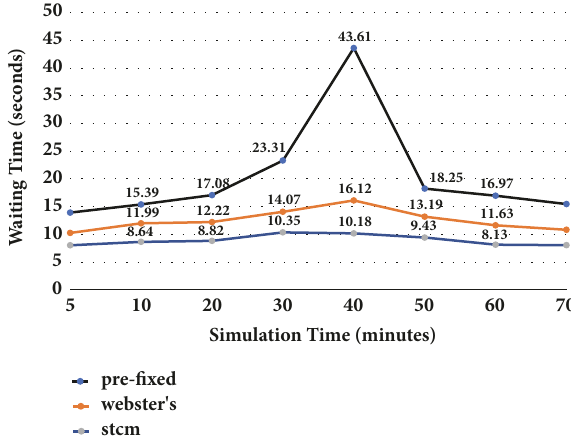
Figure 4: The comparison of the light control systems under light and medium traffic